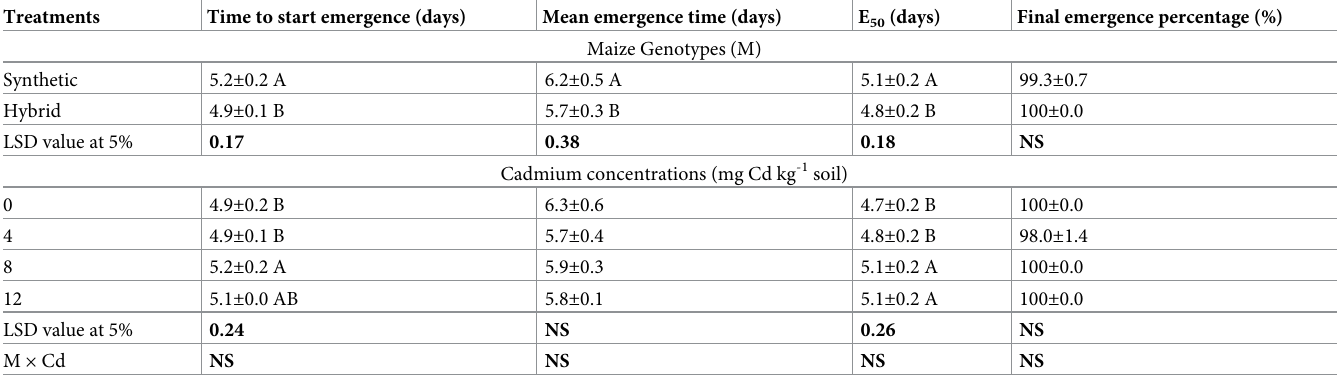
Table 1. Effect of different cadmium concentrations on seed germination and early stand establishment traits of two maize genotypes. Treatments Time to start emergence